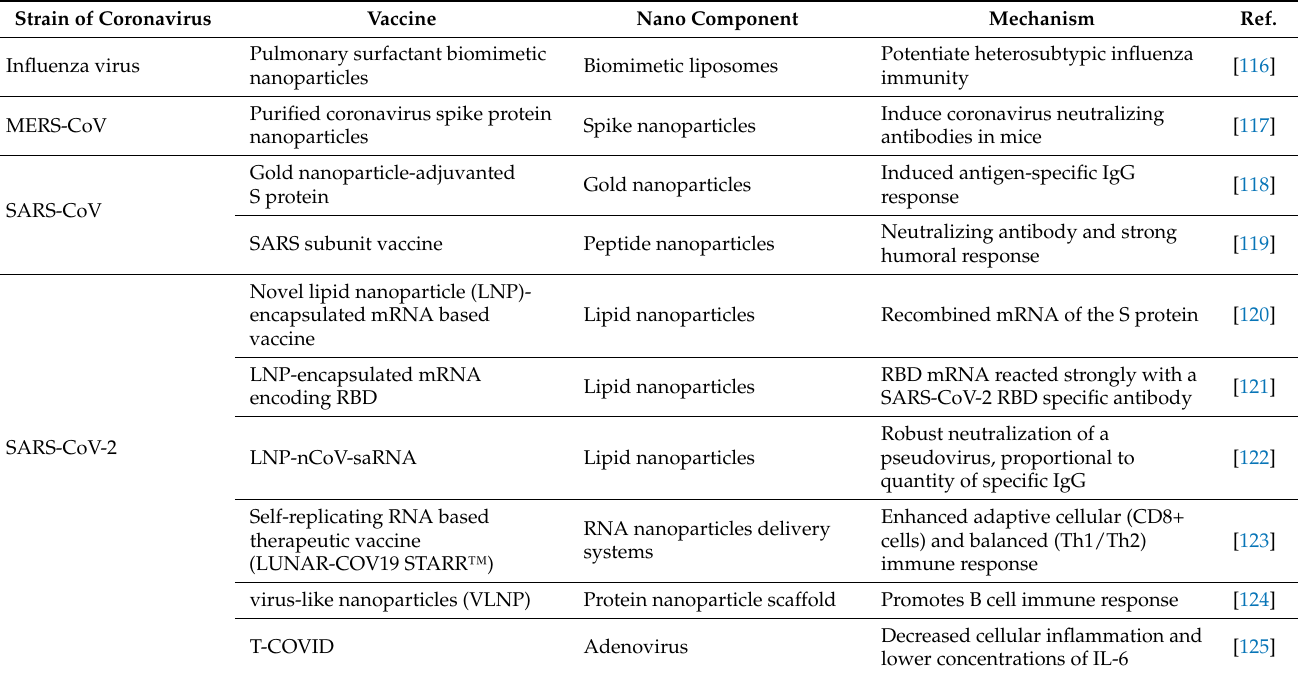
Table 3. The role of nanotechnology in vaccine